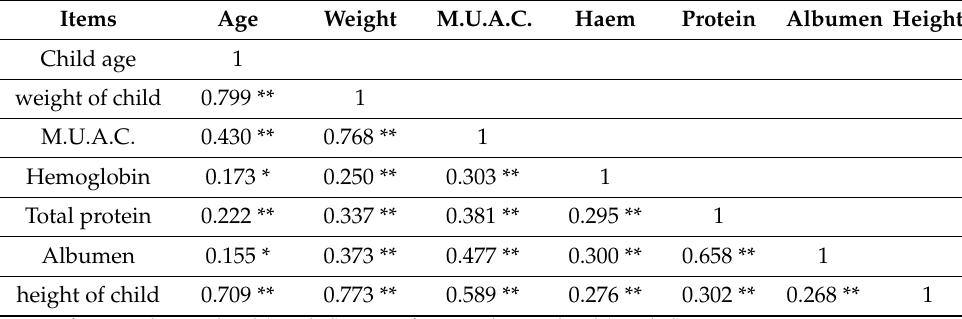
Table 2. Correlations between